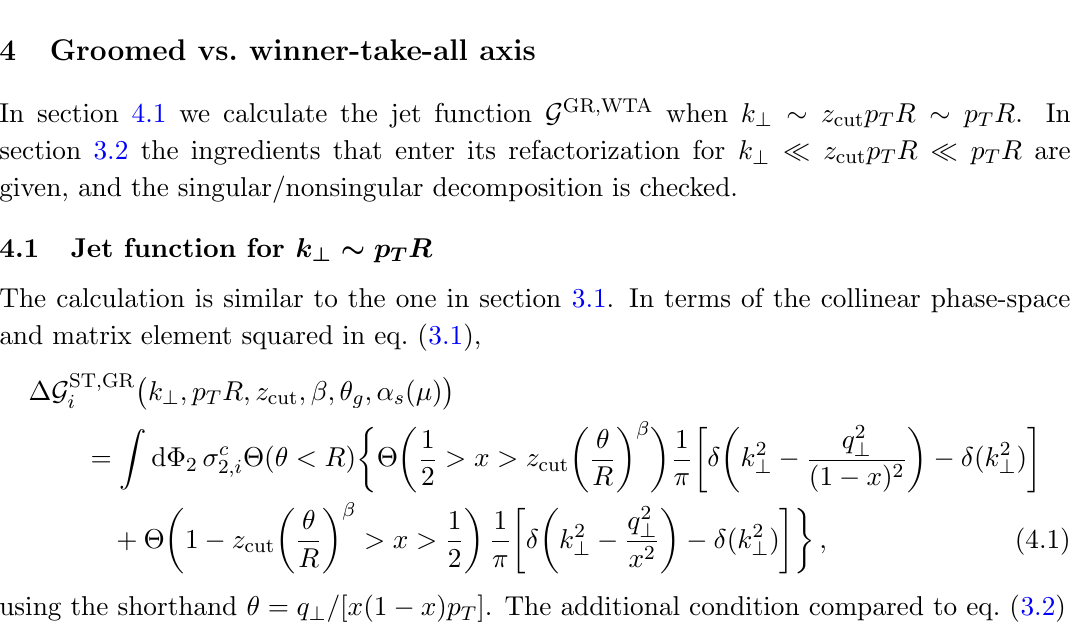
Figure 4 . Testing the refactorization (blue dashed) of the jet function (cid:1) for the angle between the standard and WTA axis in eq. (2.9) at dotted) is the di(cid:11)erence. The left (right) panel corresponds to quark (gluon)